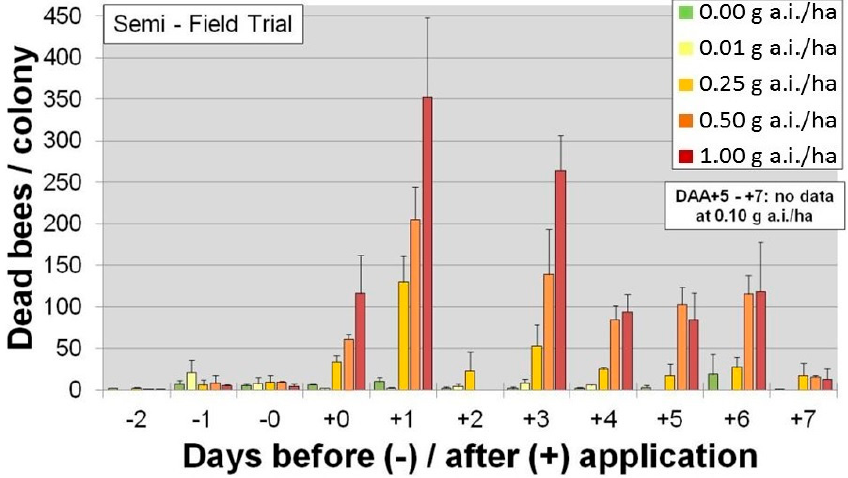
Figure 2. Honeybee mortality in a semi-field trial following manual application of dust fractions (<160 µm) length of time from application of different rates of clothianidin (g·a.i./ha) [28].